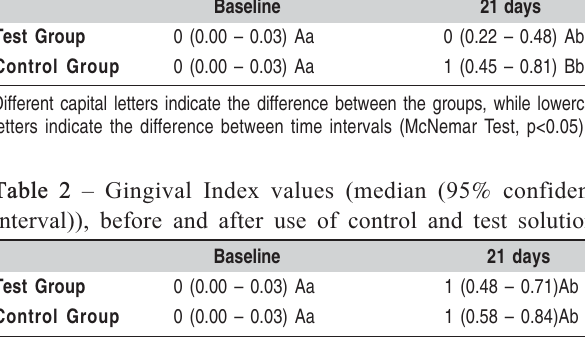
Different capital letters indicate the difference between the groups, while lowercase letters indicate the difference between time intervals (McNemar Test, p<0.05).